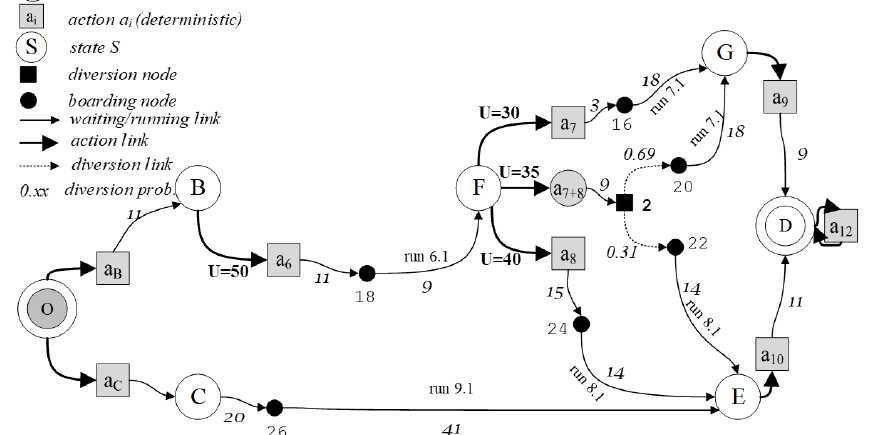
Figure 9. State action tree for the first boarding stops B and C. Table 3. Estimation of residual variance according to the forecasting horizon (refer to Figure 6). Random Residual